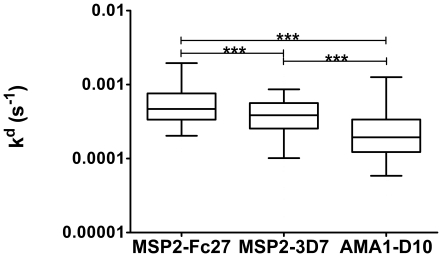
Affinity measured as kd in 219 individuals.Pattern of affinity response (measured as kd values) of exposed sera (n = 219) against recombinant proteins coupled to an SPR-chip. The increasing affinity (equals lower kd values) was observed in the order of MSP2-FC27, MSP2-3D7 and AMA1-D10 and the differences were statistically significant (p<0.0001), both when the individual proteins were compared to each other and compared across all three antigens (ns = p>0.05; * = p<0.05; ** = p<0.01; *** = p<0.001). The box plot values represent the 25th percentile, median, and the 75th percentile. The whisker range is between the 5th and 95th percentiles.